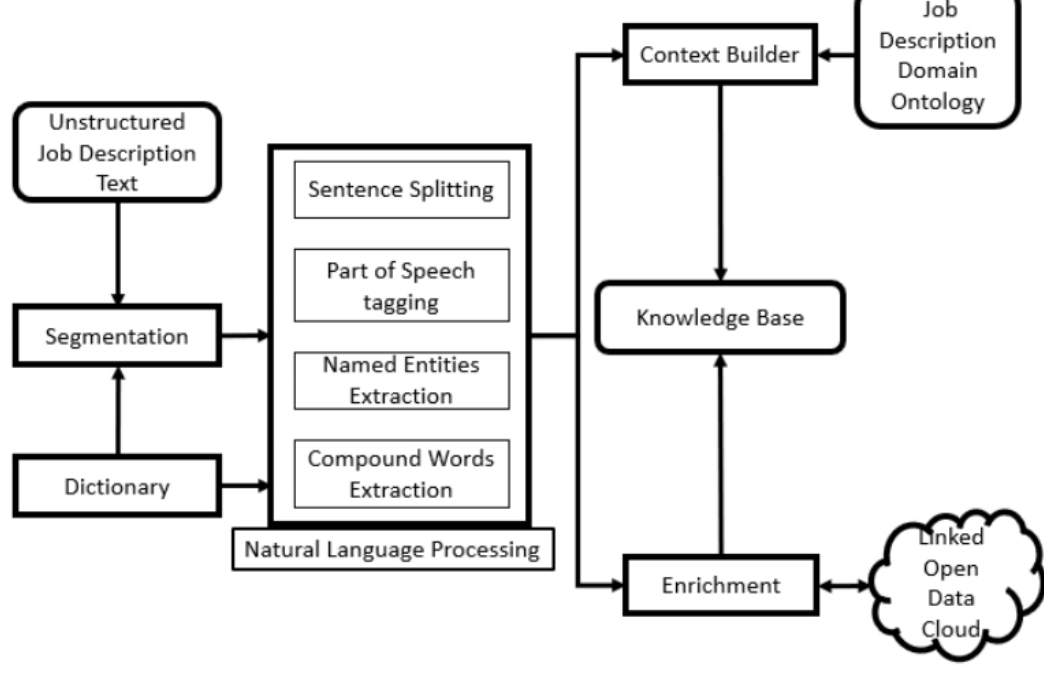
Figure 3. The proposed e-recruitment system